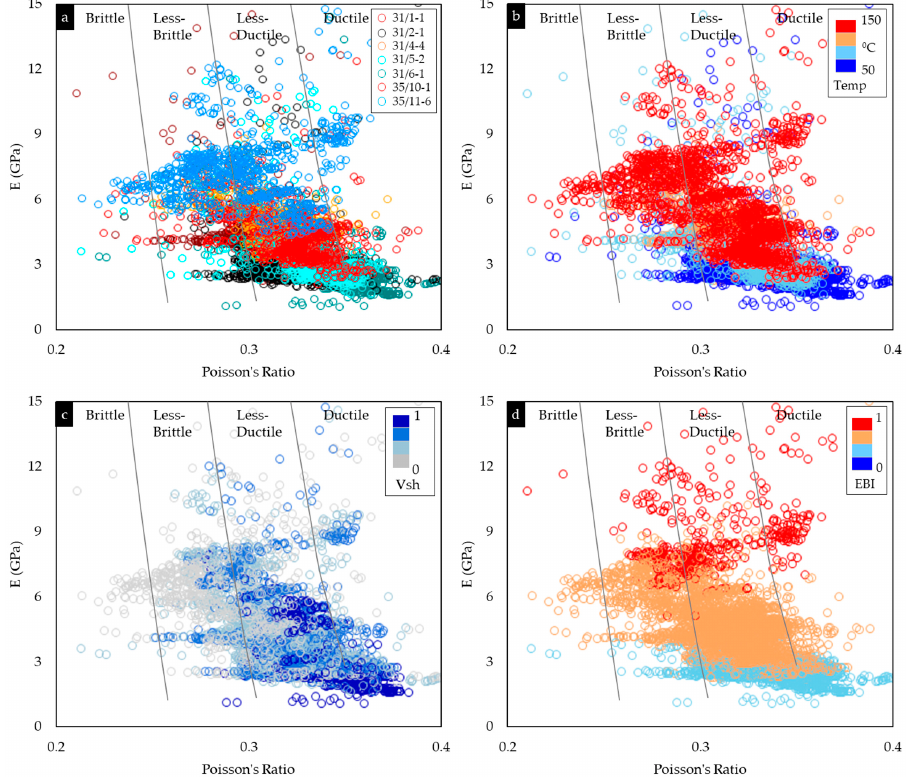
Figure 13. The diagenetic influences on geomechanical properties (E and PR) of the Drake Formation are illustrated in these cross-plots using the data points from 7 selected wells from the study area color-coded by well names ( a ), temperature corrected for exhumation ( b ), V sh ( c ), and EBI ( d ). The brittle–ductile divisions are based on Perez and Marfurt [50] published curves.